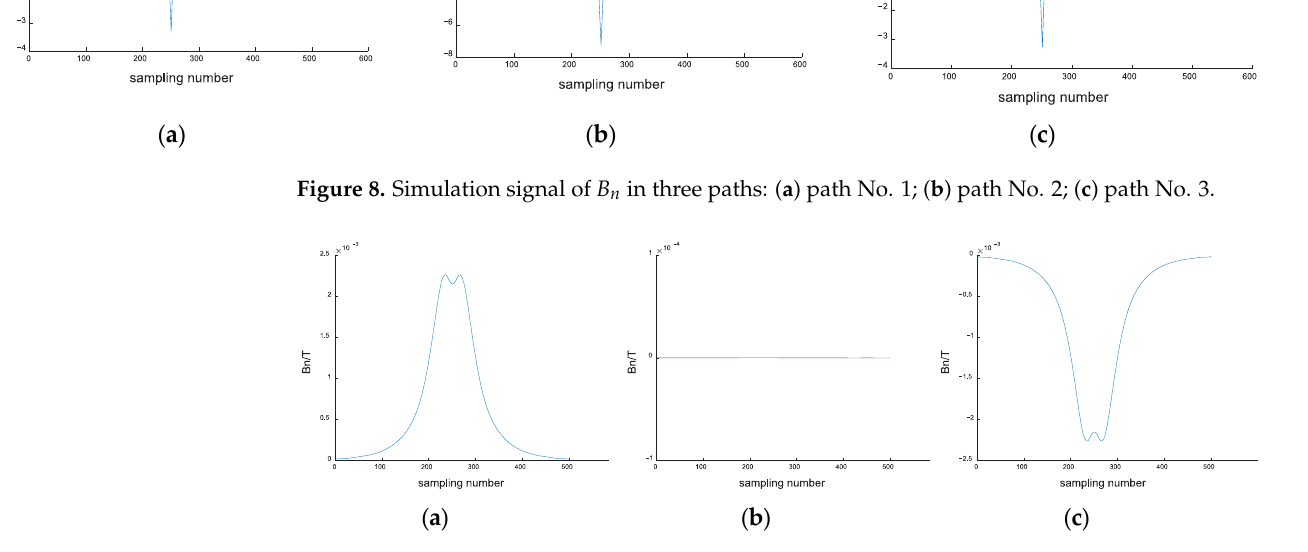
Figure 9. Simulation signal of B t in three paths: ( a ) path No. 1; ( b ) path No. 2; ( c ) path No. 3.